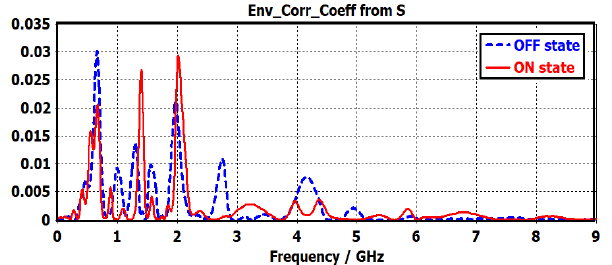
FIGURE 14. ECC curve of the proposed MIMO antenna